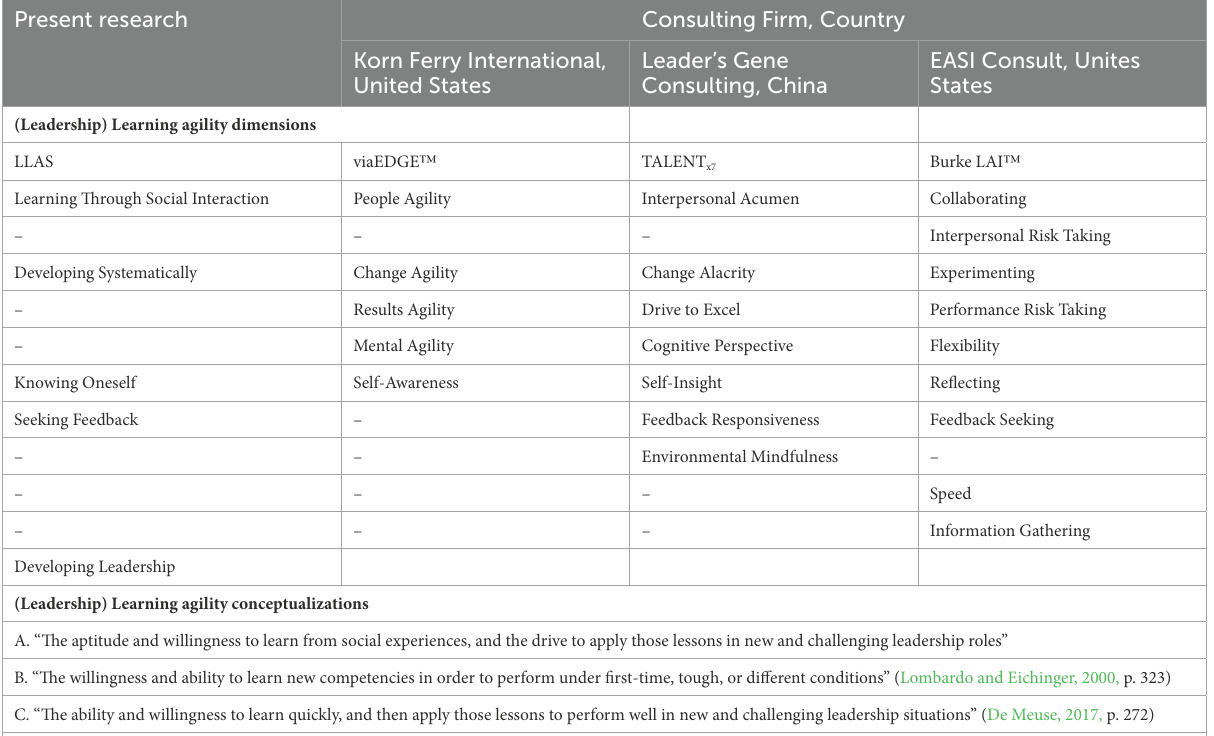
TABLE 1 Leadership learning agility domain compared with three commercial